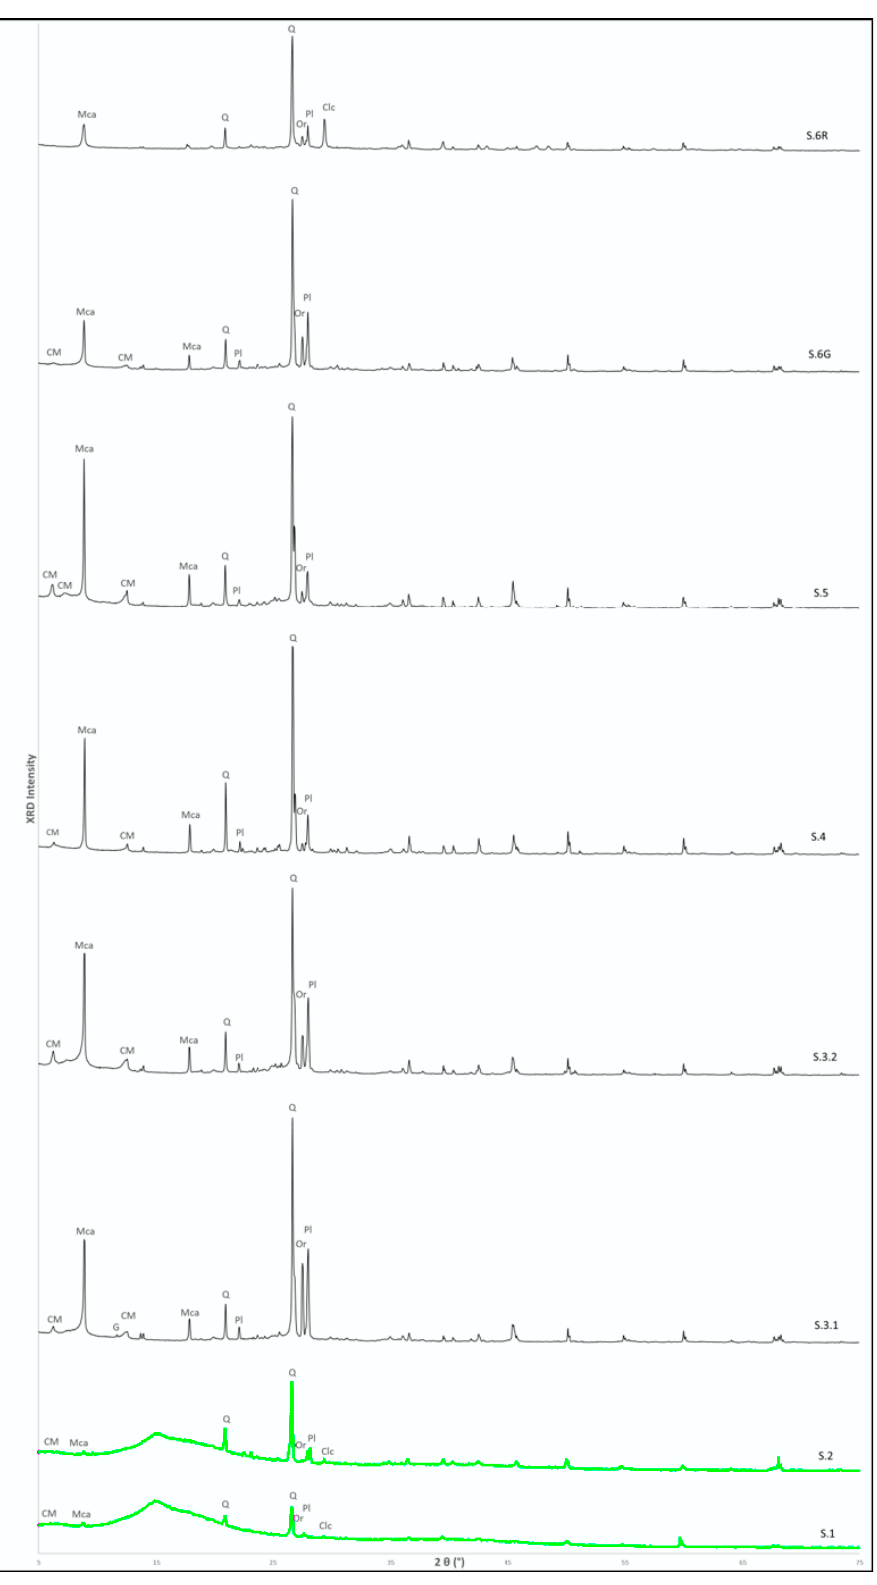
Figure 4. XRD patterns of the samples. Color coded by group. Group 1: organic binder samples—blue, Group 2: inorganic binder samples—black. Q, quartz; Pl, plagioclase; Or, potassium feldspar; Mca, mica; Clc, calcite; CM, clay